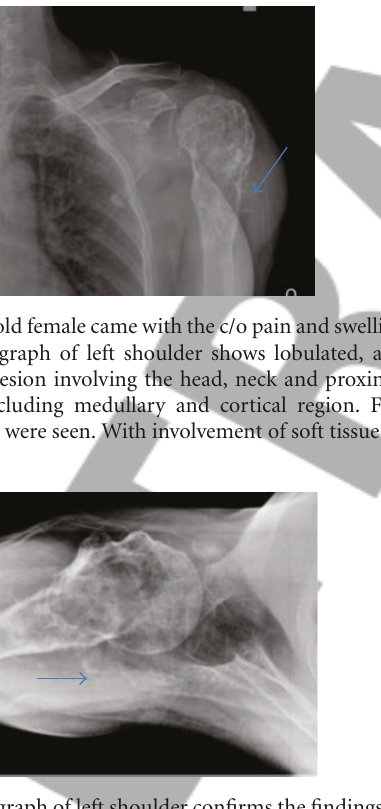
Figure 3: Axial radiograph of left shoulder confirms the findings of the AP radiograph and shows soft tissue swelling with few specks of calcification